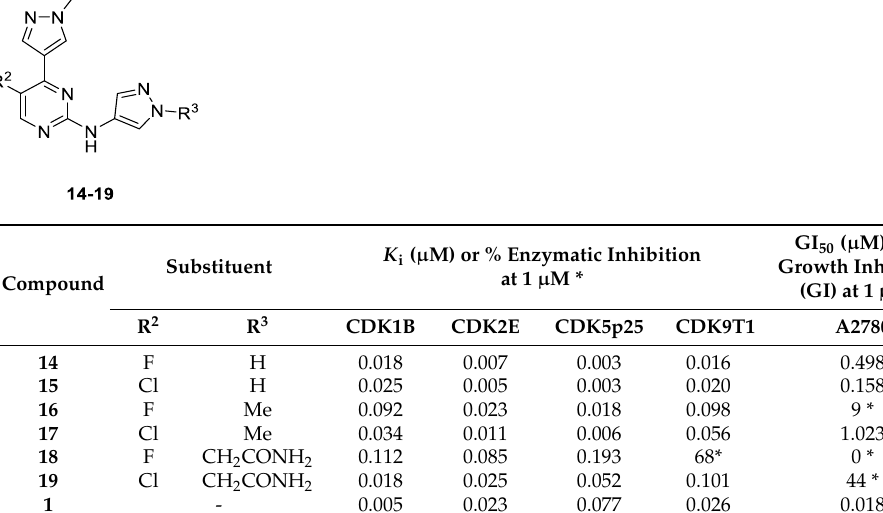
Table 1. Inhibition of CDK kinase activity and A2780 cell viability by 14 – 19 .